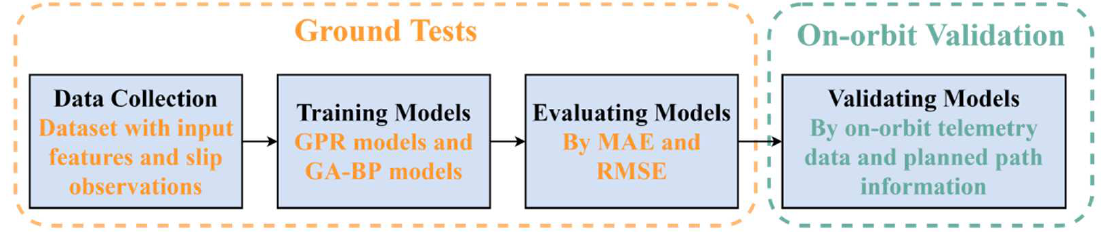
Figure 3. Research framework.